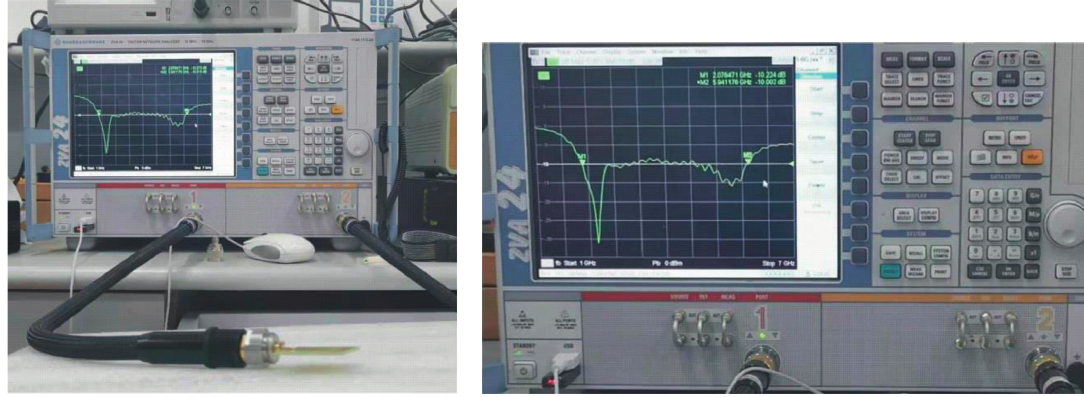
Figure 10: Photograph of VNA